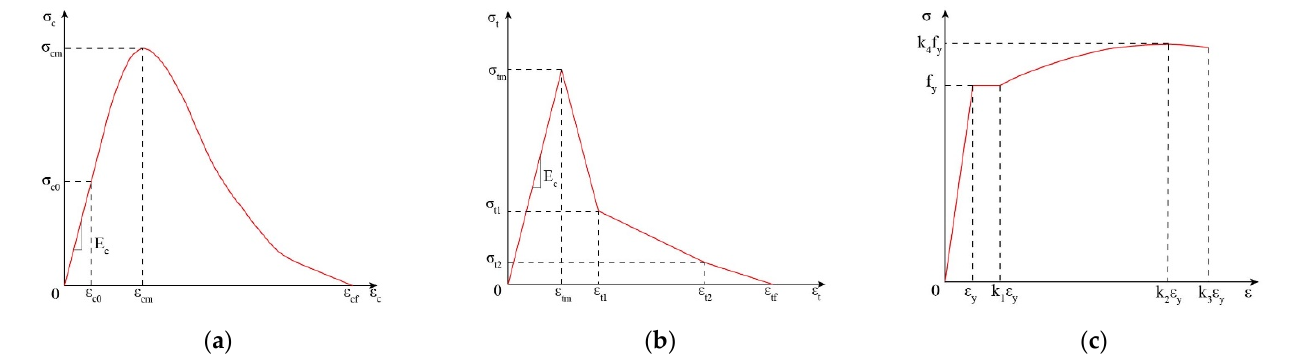
Figure 12. Constitutive law of material: ( a ) uniaxial compression of concrete, ( b ) uniaxial tension, ( c ) uniaxial tension for rebar.